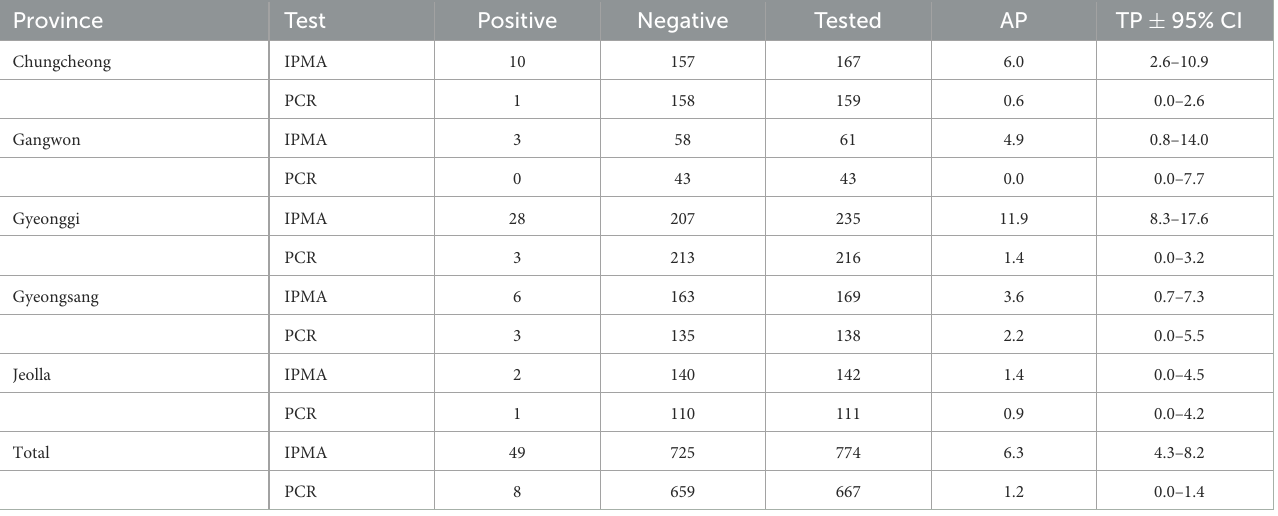
TABLE 1 Prevalence of antibodies to and shedding of Lawsonia intracellularis in farmed rabbits in South Korea. Province